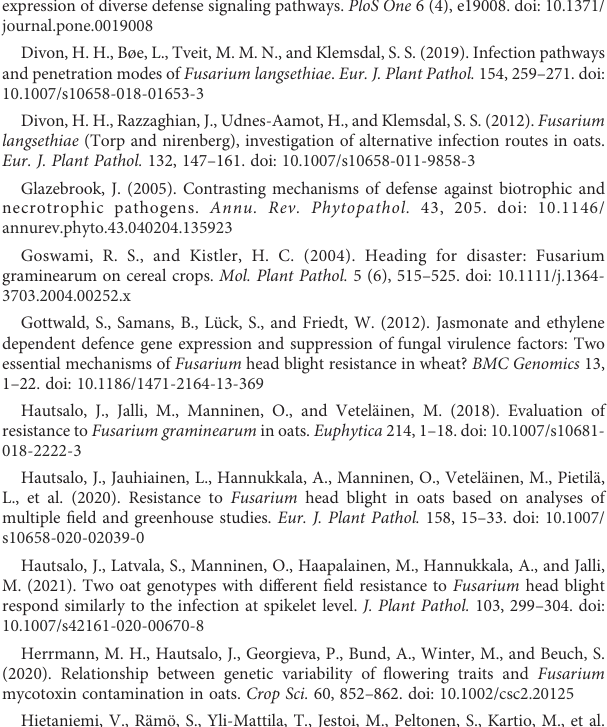
SUPPLEMENTARY FIGURE 1 Daily statistical signi fi cances of time course analysis. Spikelet vitality (A) F. langsethie (B) F. culmorum . Spikelet photosynthetically active area (C) F. langsethiae and (D) F. culmorum . Dotted line adjusted P value =